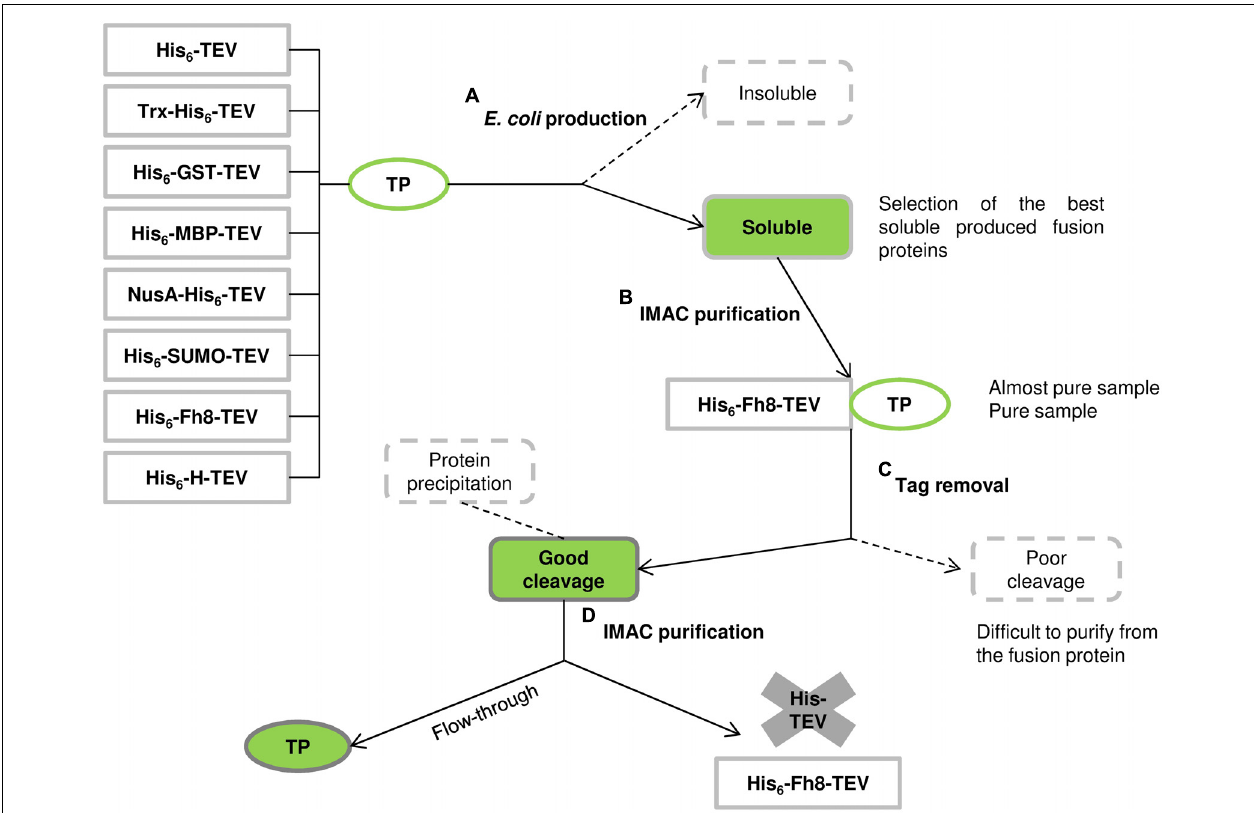
FIGURE 2 | Schematic pathway from protein production to purification using the solubility tags and the hexahistidine (His 6 ) affinity tag of the comparison conducted by Costa etal. (2013a; adapted from Esposito and Chatterjee, 2006). (A) Eight tagged versions of theTP were expressed in E. coli : some fusions can end-up in the insoluble fraction whereas others remain in the soluble fraction. (B) Soluble fusion proteins are then purified by immobilized metal affinity chromatography (IMAC) using the His 6 tag and the